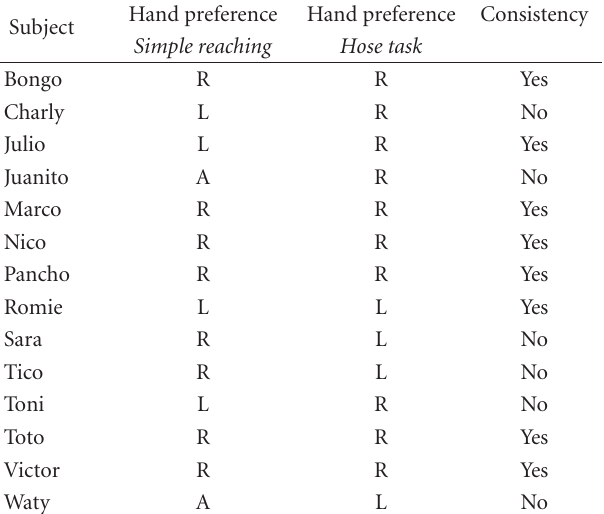
Table 1: Hand preferences and consistency for simple reaching and hose task at the FM chimpanzees. R: right-hand preference. L: left- hand preference. A: